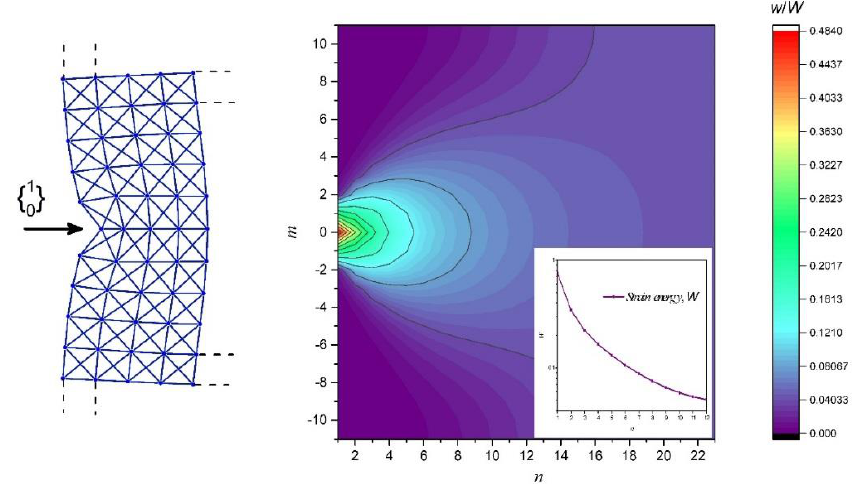
Figure 13. A contour map of normalized strain energy distribution of an x-braced lattice having 𝑘 = 0.93 with dimensions, 𝑚 = 22 and 𝑛 = 22 , under a point load, 𝐟 0𝑚 = total strain energy in a vertical layer of unit cell thickness vs. the lattice index, 𝑛